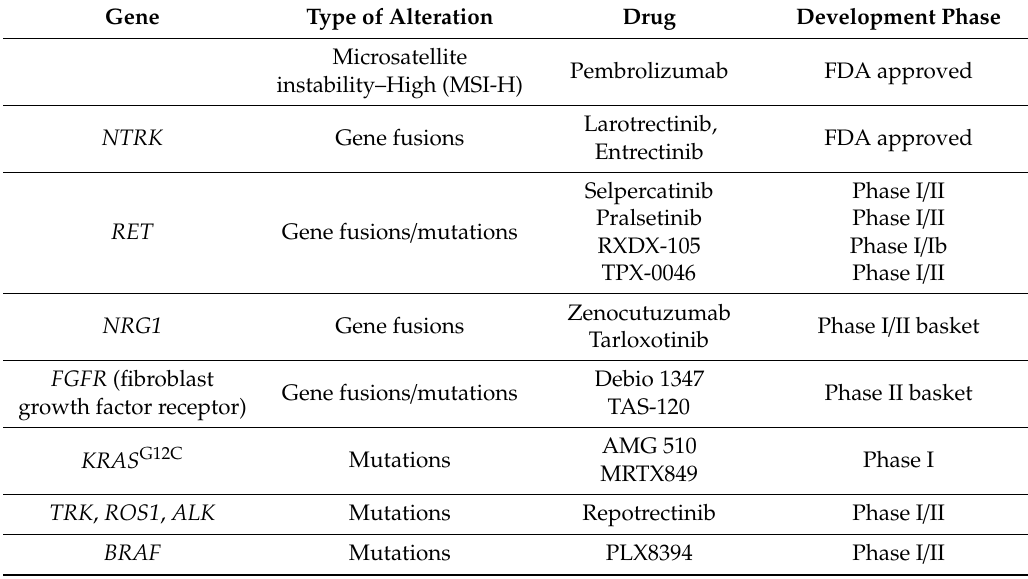
Table 2. Molecular alterations with agnostic indications approved or in development